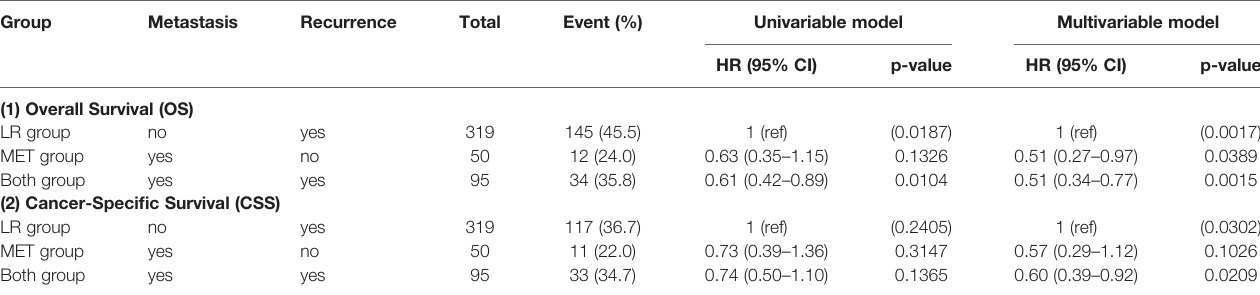
TABLE 2 | Univariable and multivariable Cox proportional hazard models for overall survival (OS) and cancer-speci fi c survival (CSS) among three groups. Group